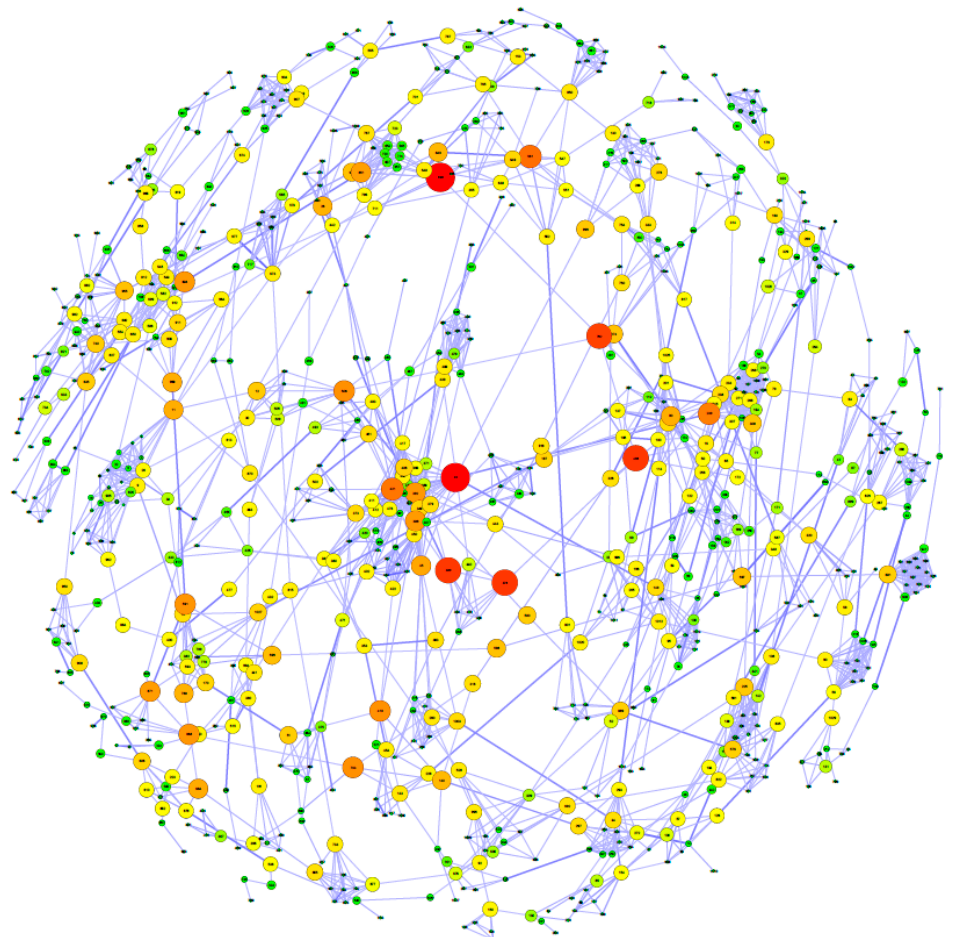
Figure 2. Pedigromics. This figure shows the relationship (> 0.2) among the individuals included in this study. Each node represents one animal from the population; those animals not related to the main population were filtered. The colour and the size of the nodes are based on the betweenness coefficient, on a green to a red colour scale, with the higher values represented by a large size and red colour. The width of the connection line (edge) depends on the values of the off-diagonal elements in the GRM.